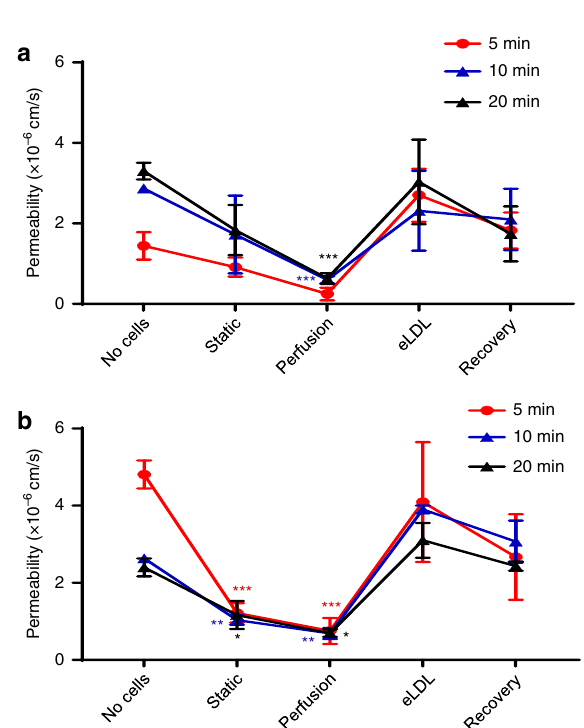
Fig. 4 Perfusion reduces TEBV EC permeability. Permeability of TEBVs to 20 µ g/ml of FITC-dextran (500 kDa) ( a ) and to 10 μ g/ml of FITC-IgG ( b ). The groups are collagen tubing without cells and without perfusion (No cells), TEBVs with cells under static culture of 1 week (Static), TEBVs with cells for 1-week perfusion perfused at 0.5 ml/min per TEBV (0.4 Pa) (perfusion), TEBVs under 1-week perfusion followed by 96 h perfusion